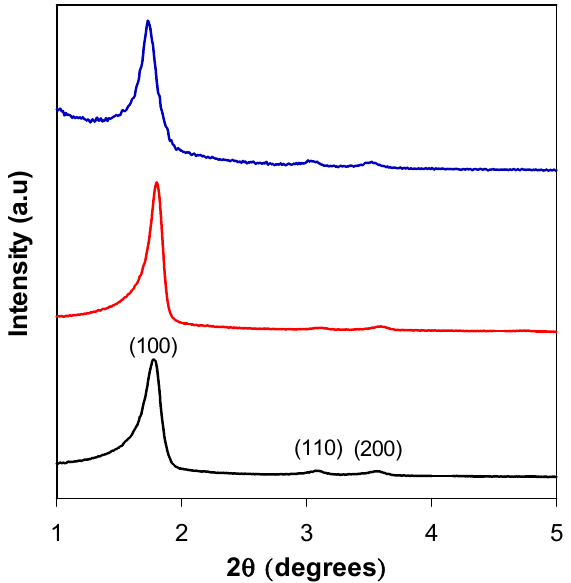
Figure 1. PXRD of Cl-EtPMO (black line), Im-EtPMO (red line), and Im-EtPMO-Co (blue line). Transmission electron microscopy (TEM) images of Cl-EtPMO, Im-EtPMO, and Im-EtPMO-Co materials are depicted in Figure 2. TEM images showed that all PMO materials had highly ordered structures with uniform and parallel channel pores, which confirmed the findings obtained by XRD.